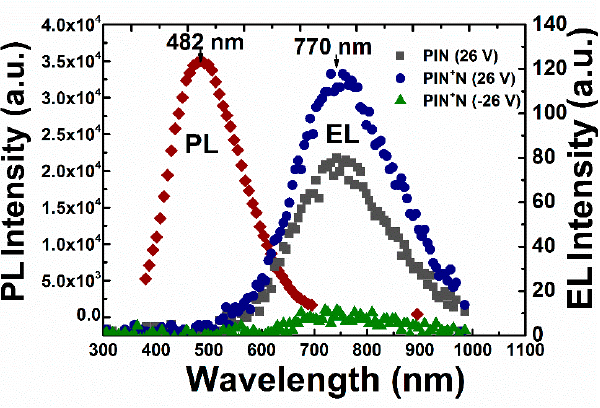
Figure 4. PL intensity spectra of a-Si 1 − x C x :H active layer and EL intensity spectra of the PIN (in FB) and PIN + N (in FB and RB) devices.